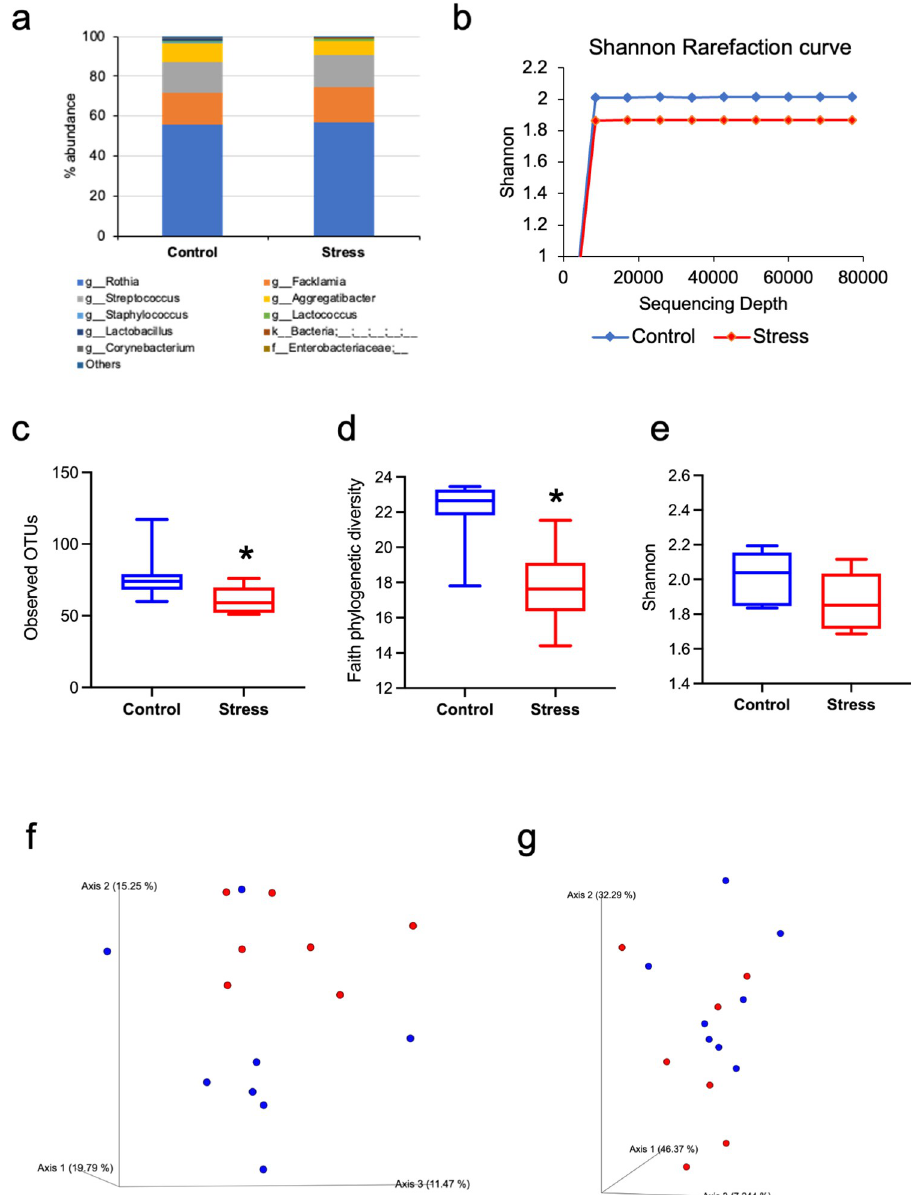
Fig 3. The results of the oral microbiota analysis. (a) The taxonomic abundance shows that oral microbiota was dominated by genus such as Rothia , Facklamia and Streptococcus in both groups. (b) The rarefaction curves plateaued in both the groups indicating sufficient depth of analysis (control group, blue line; stress group, red line). The alpha diversity, as measured by the (c) observed OTUs, (d) faith phylogenetic diversity and (e) Shannon index. The observed OTUs and faith phylogenetic diversity was significantly lower in the stress group compared to that in the control group ( � p = 0.02, both; Kruskal-Wallis test). The beta diversity, as measured by the (f) unweighted UniFrac and (g) weighted UniFrac, showed some differences in clustering between the two groups, statistical significance notwithstanding (control group, blue dots; stress group, red